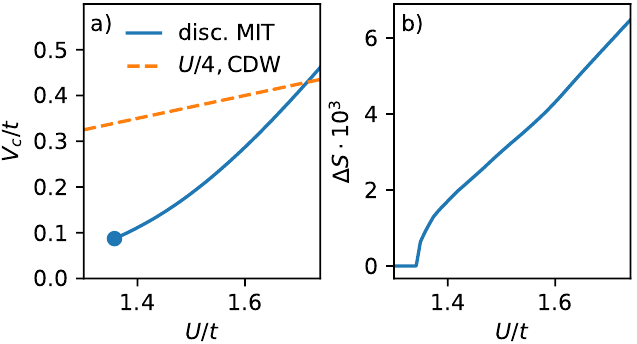
Figure 6: (Color online) a) Critical nonlocal interaction V transition takes place. The dot marks the smallest U / t at which a first-order transition takes place. b) Change of the entropy due to the phase transition. The temperature is T / t = 0.079 for a) and